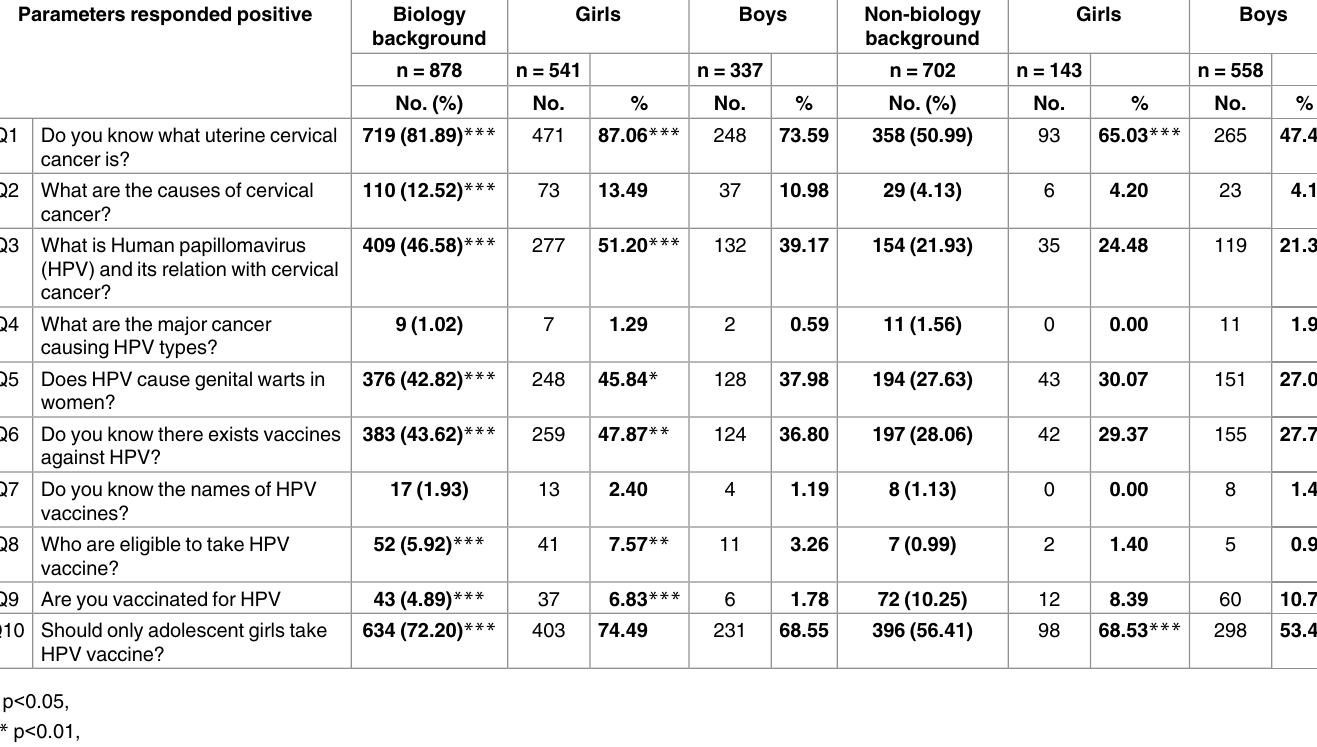
Table 3. Knowledge about cervicalcancer and HPV among college students based on their academic subject background. Parameters responded